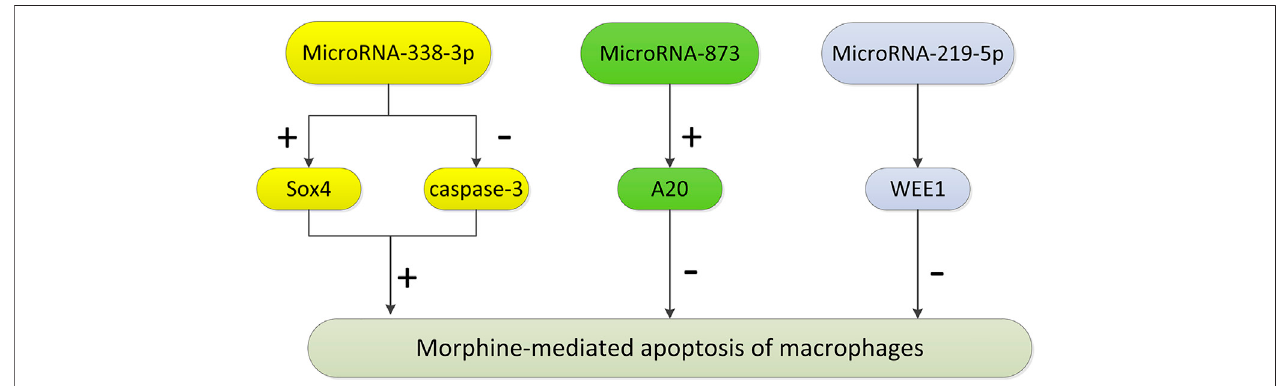
FIGURE2| Thepathways regulatedbymicroRNAsinmorphine-mediated apoptosis ofmacrophages. Aftermorphine treatment, theexpression level ofmiR-338- 3p in peritoneal macrophages increased signi fi cantly, which decreased the expression level of Sox4, leading to the increase of caspase-3 expression level, and then promoting cell apoptosis. MicroRNA-873 inhibits morphine-induced macrophage apoptosis by increasing the expression of A20. MicroRNA-219-5p inhibits morphine- induced apoptosis by targeting WEE1, the key cell cycle regulator. ( “ + ” represents promotion, and “ − ” represents